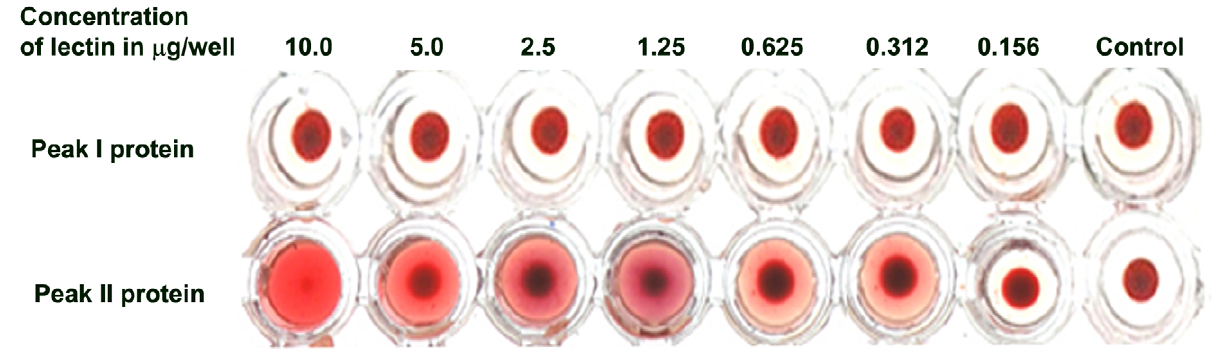
Figure 3. Hemagglutination activity of peak I and peak II protein isolates after 60% ammonium sulphate precipitation of Aegle marmelos fruit extract. Peak I and peak II protein from 60% ammonium sulphate precipitate of Aegle marmelos fruit extract were serially diluted and 4% of blood-group-O erythrocytes were added to assess hemagglutinating activity. Peak II protein alone showed complete hemagglutinating activity at 10 m g/well.